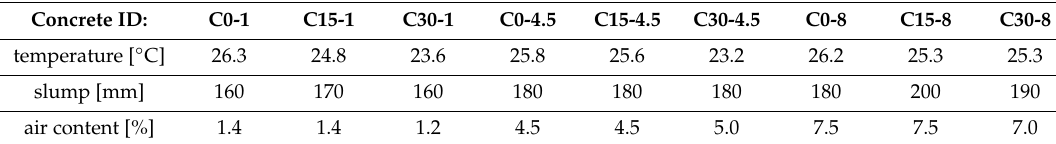
Table 4. Selected properties of concrete